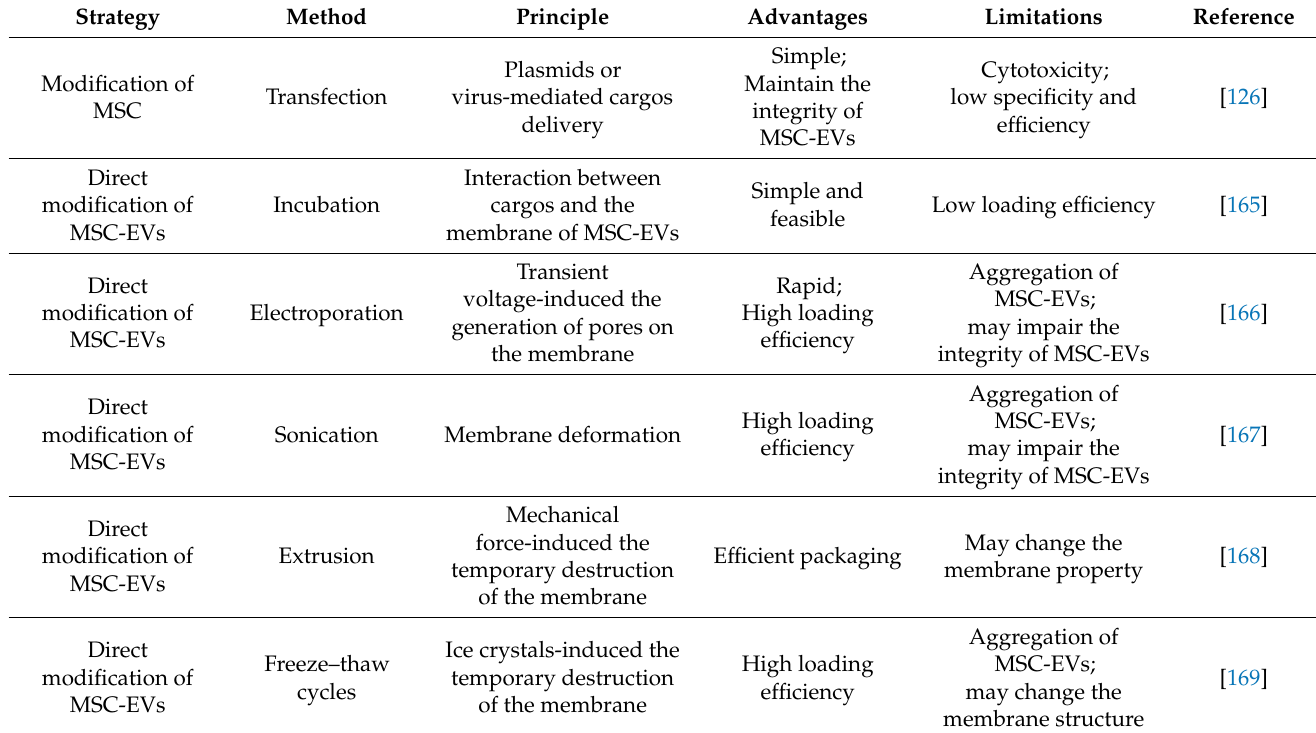
Table 4. Evaluation of strategies for cargo loading into